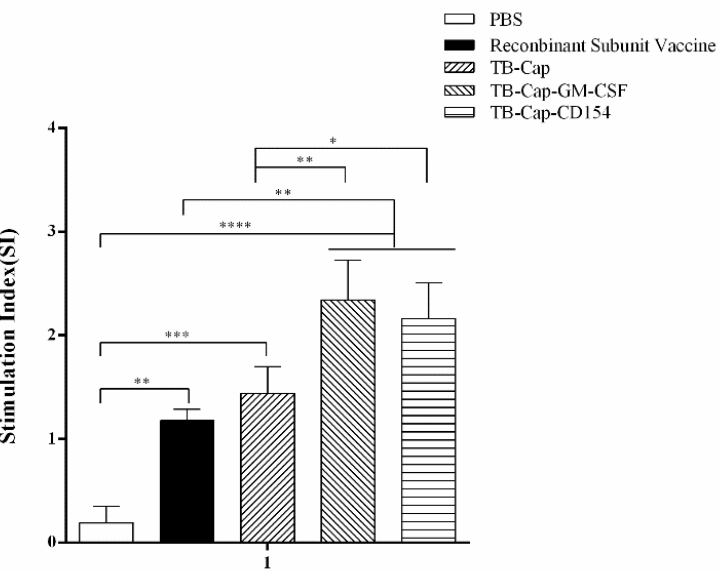
Figure 6. Lymphocyte proliferation levels in different groups. On day 42 after the first immuniza- tion, lymphocytes were collected and the proliferation was detected by CCK-8. The stimulation in- dex (SI) = (mean OD 450 nm of PCV2 stimulated cells − mean OD 450 nm of negative control cells)/(mean OD 450 nm of positive control cells− mean OD 450 nm of negative control cells). Data represent the mean ± SD. An asterisk (*) shows a statistically significant difference between the indicated groups ( p <